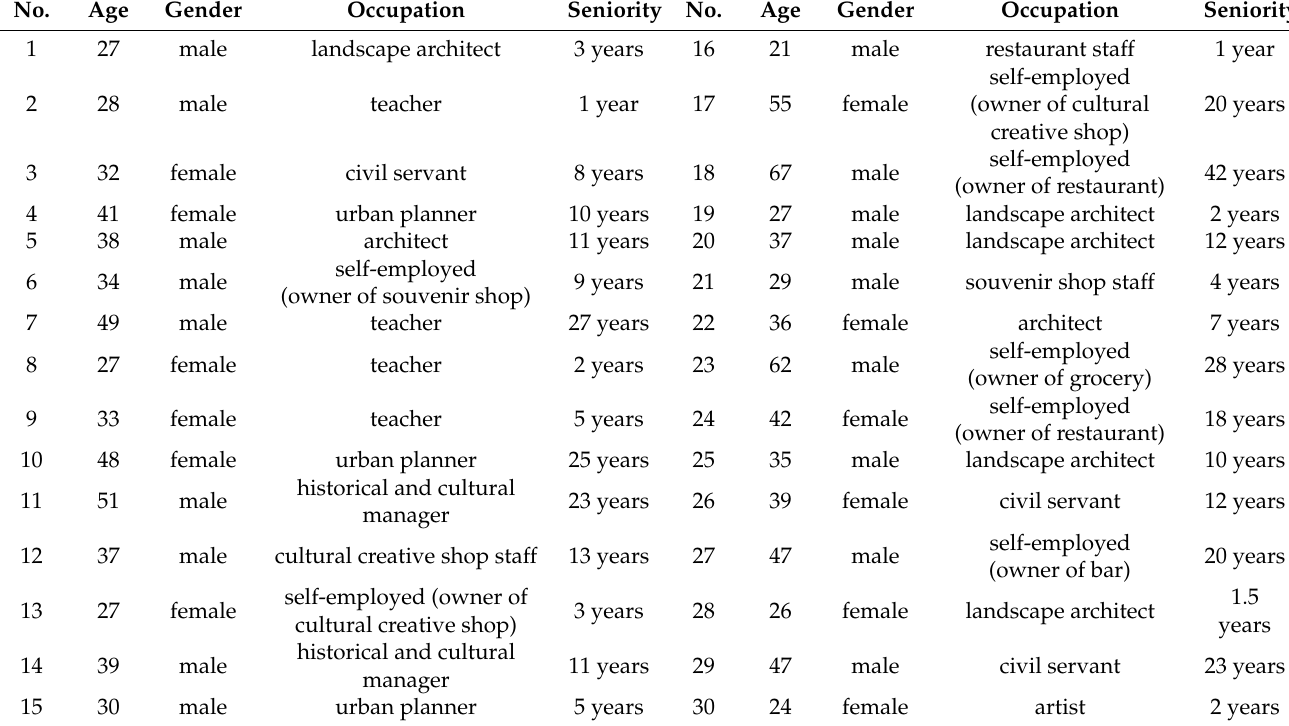
Table 1. Profile of anonymous